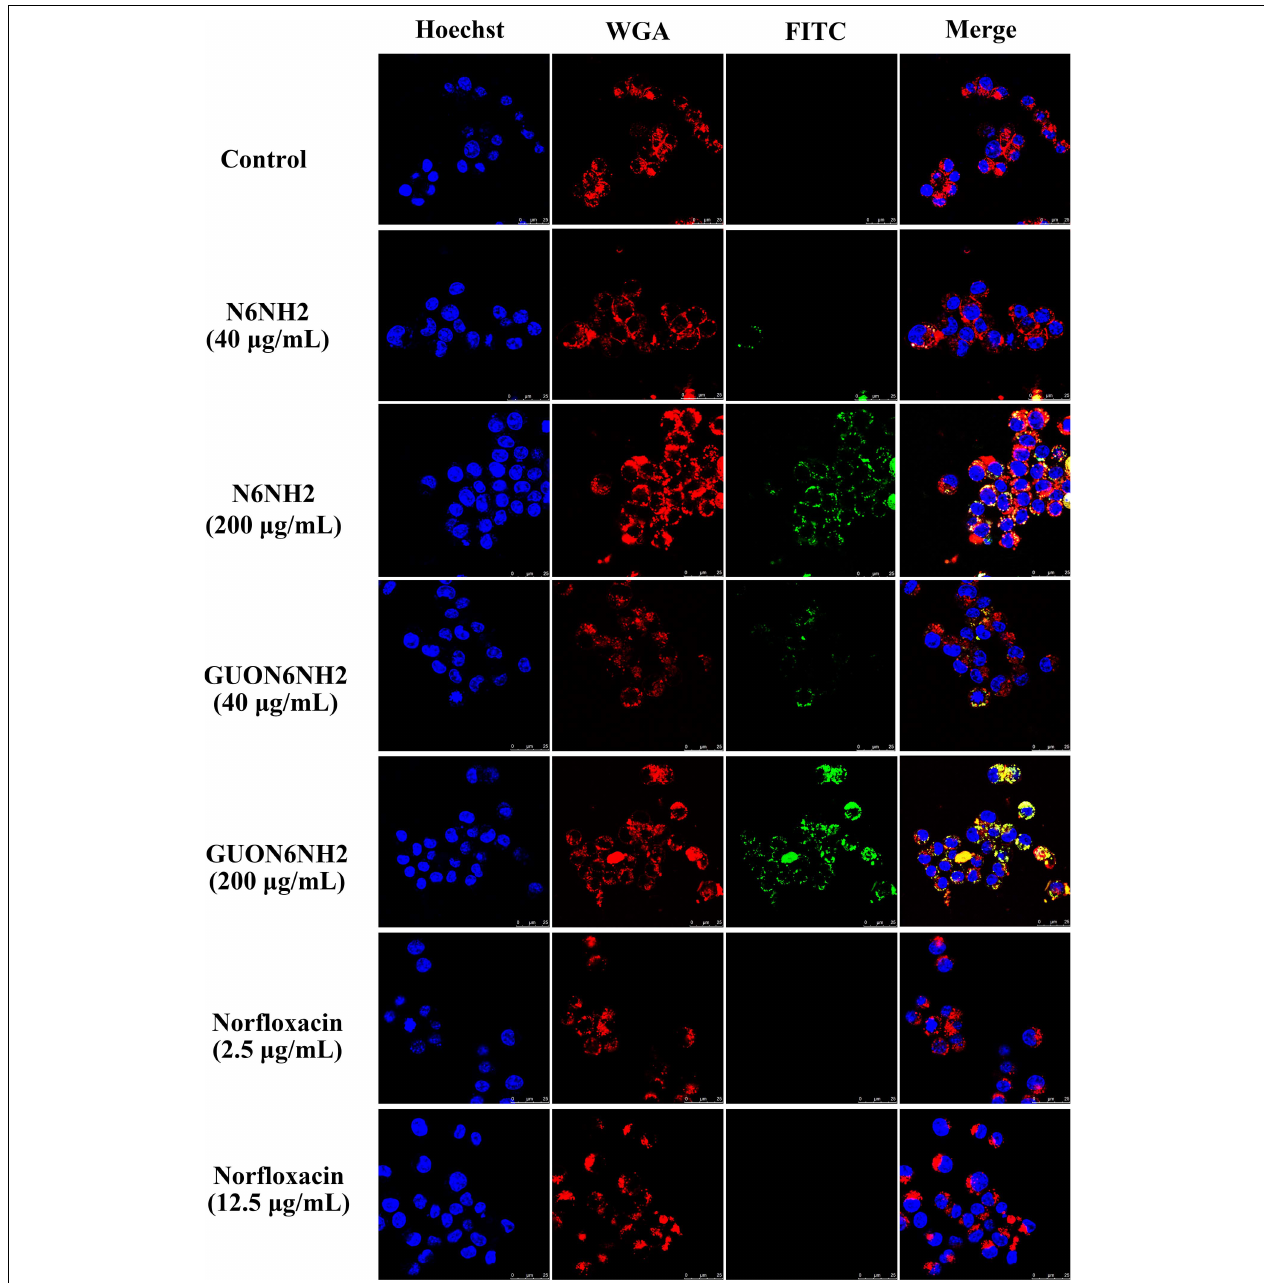
FIGURE 6 | Cellular distribution of N6NH2 and GUON6NH2 in RAW 264.7 cells. Cells were incubated with 40 or 2.5 (5 × MIC) and 200 or 12.5 µ g/mL (25 × MIC) FITC-labeled peptides or antibiotic at 37 ◦ C for 18 h before washing and analysis by confocal microscopy. Cell membrane and nucleus were stained with WGA-conjugated Alexa Fluor 555 (red) and Hoechst 33342 (blue), respectively. FITC-N6NH2 and GUON6NH2 inside cells displayed green fluorescence and were uniformly distributed in the cytoplasm. GUON6NH2 showed higher uptake than N6NH2, but FITC-labeled norfloxacin was not able to enter the